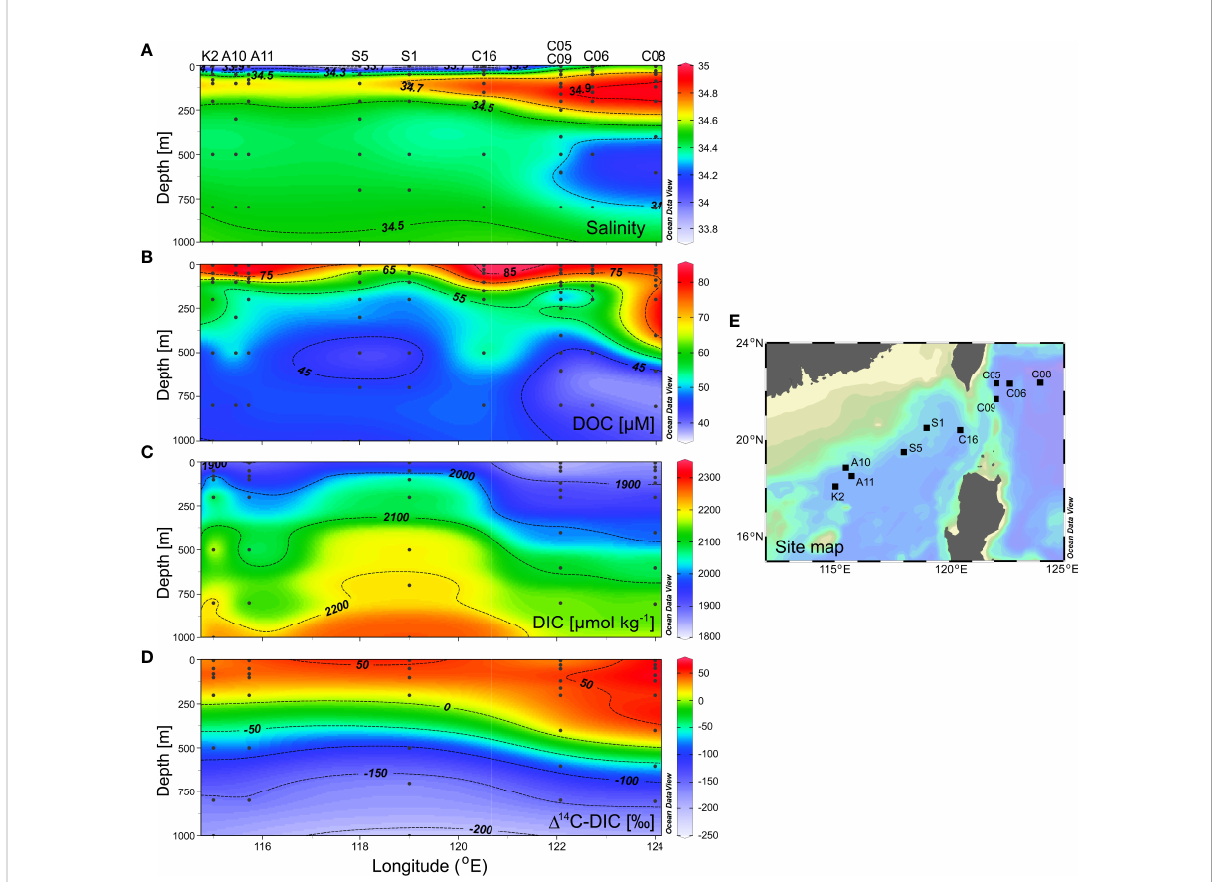
FIGURE 8 Transectional distribution of (A) salinity, (B) DOC concentrations, (C) DIC concentrations and (D) D 14 C-DIC values for (E) stations sampled from west to the east across the Luzon Strait using ODV (Schlitzer, 2017). Note that DIC concentrations and D 14 C-DIC values are provided for only fi ve stations in panel (C, D) due to the lack of data at stations C09, C16, S5 and A10 (Ding et al.,